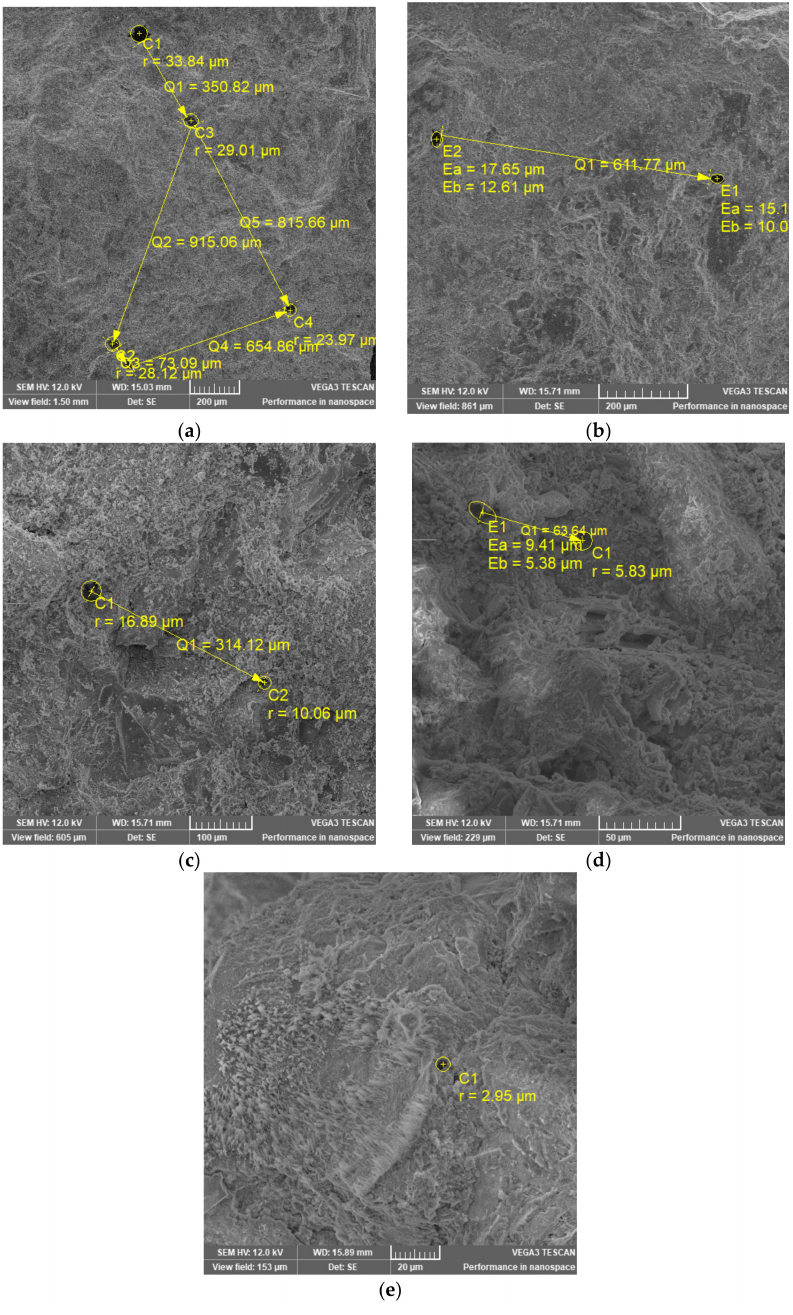
Figure 10. SEM images of S360 ( a ), S414 ( b ), S54/20 ( c ), S54/40 ( d ) and S54/60 ( e